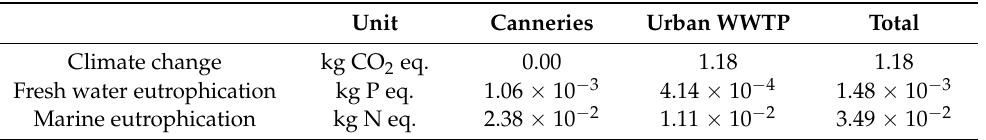
Table 7. Characterization of the environmental impact of the discharge of 1 m 3 equivalent to sewerage from the urban WWTP and